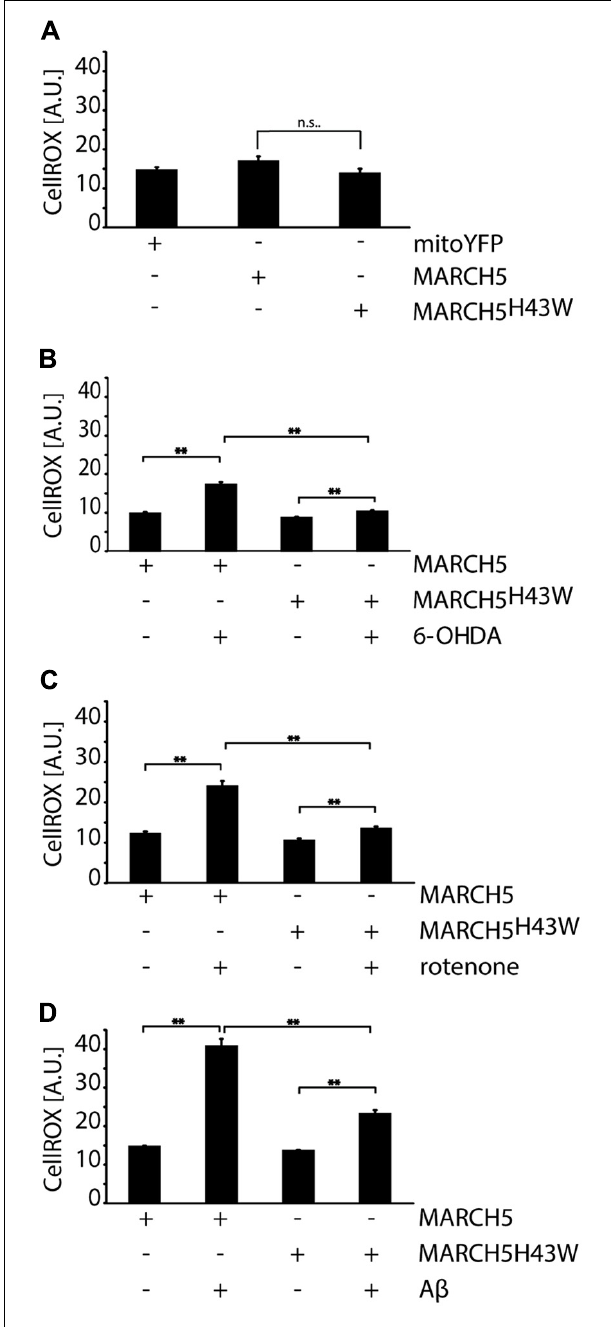
FIGURE 5 | Inactivation of MARCH5 blunts ROS production under neurodegenerative stress conditions . (A) SH-SY5Y cells expressing mitoYFP, MARCH5-YFP, or MARCH5 H43W -YFP were treated with the ROS-sensitive dye CellROX and intracellular ROS levels were measured using image analysis of confocal pictures. SH-SY5Y cells expressing MARCH5-YFP or MARCH5 H43W -YFP were treated with 75 μ M 6-hydroxydopamine for 6 h (B) , 5 μ M rotenone for 6 h (C) , or 25 μ M A β peptide for 24 h (D) and mitochondrial membrane potential was measured as in (A) . Shown is the average of four independent experiments with 10 cells per condition. Statistical significance was analyzed using Student’s t -test with ** marking p < 0.01 and n.s. marking no significant difference. Error bars represent